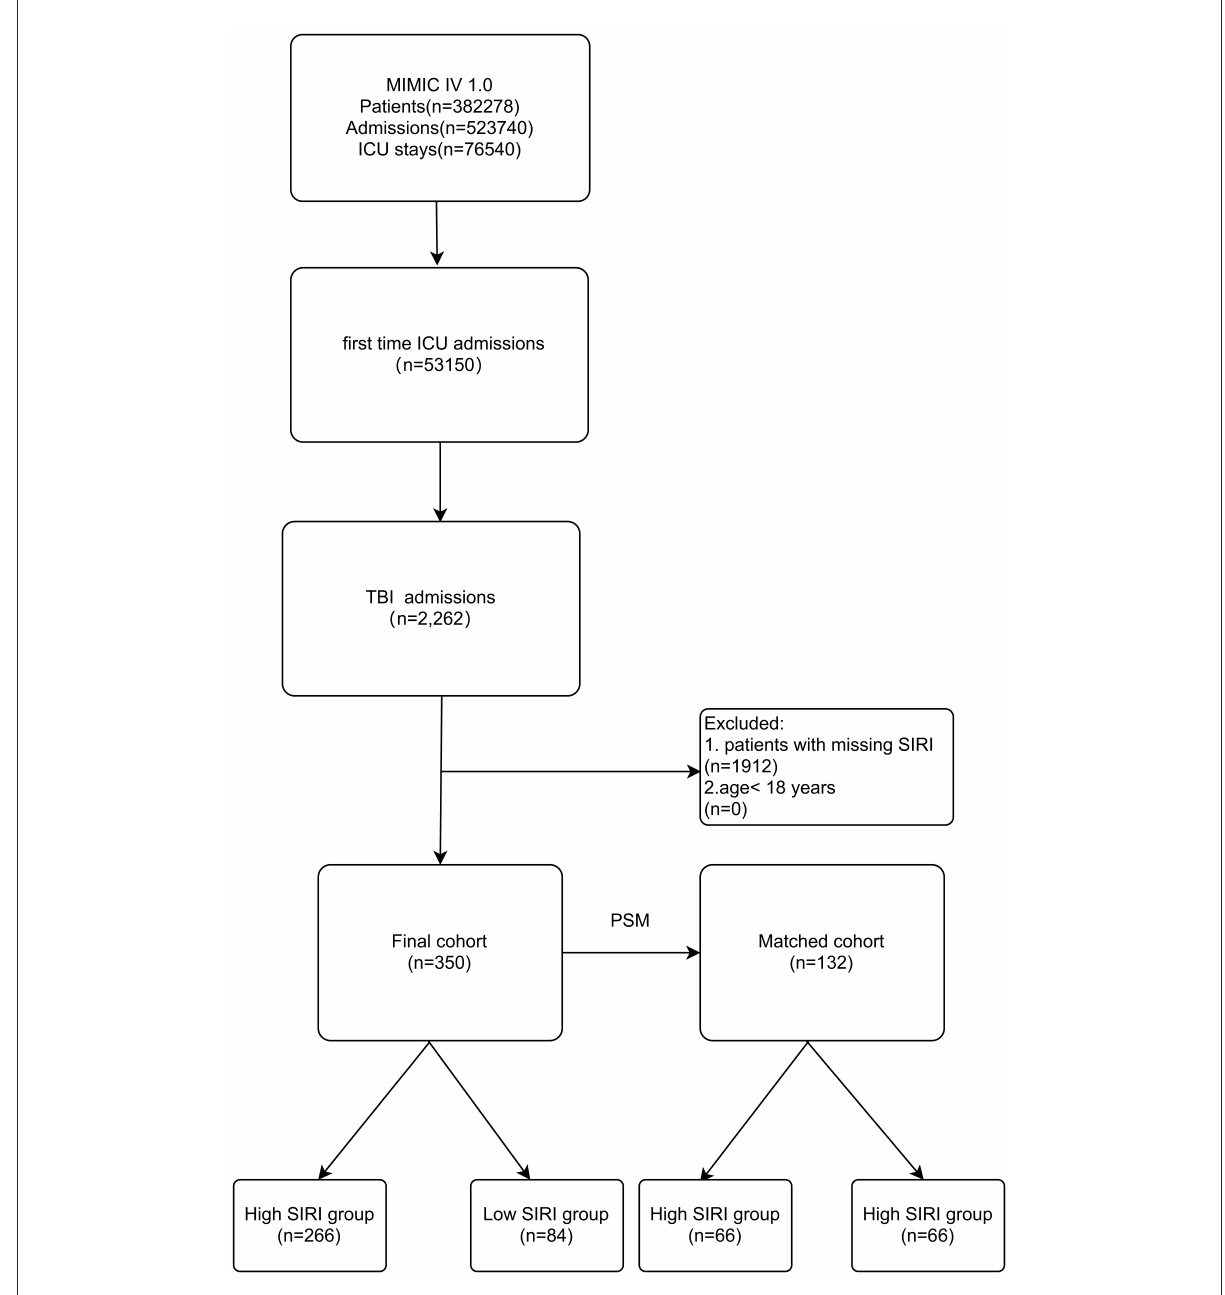
FIGURE1 Study flow diagram in the present